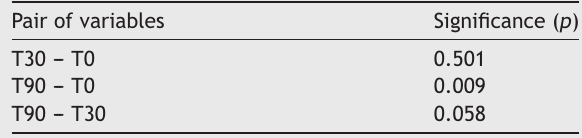
Fundamental frequency analysis (Fo) --- Vowel